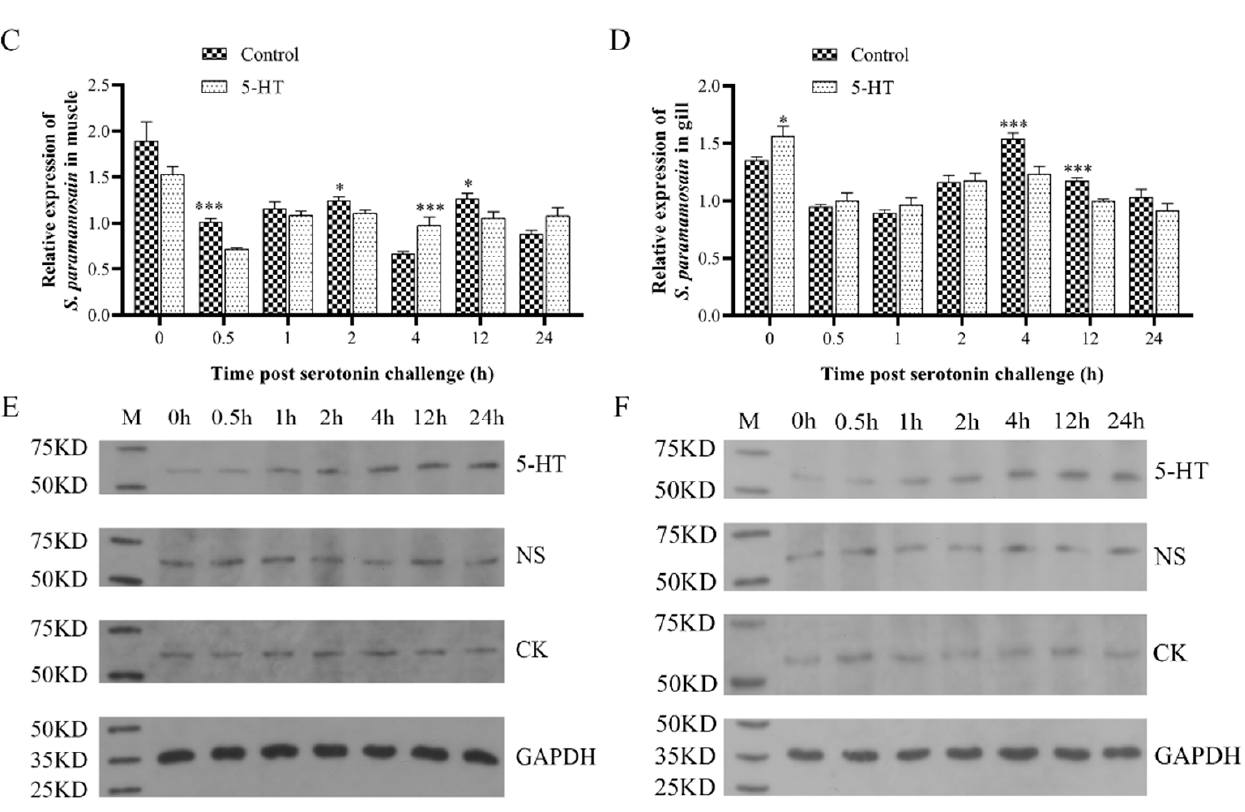
Figure 4. Sp5-HTR1 mRNA expression levels in the ( A ) thoracic ganglion, ( B ) cerebral ganglion, ( C ) muscle, and ( D ) gill of S. paramamosain injected with 5-HT. Sp5-HTR1 protein expression levels in the ( E ) thoracic ganglion and ( F ) cerebral ganglion of S. paramamosain injected with 5-HT. ( A – D ) Bars correspond to the standard deviation (SD) of the mean values ( n = 3). Asterisks indicate signif- icant differences. * p < 0.05; *** p < 0.01. Abbreviations: CK, control check group; NS, normal saline group; GAPDH, internal standard.